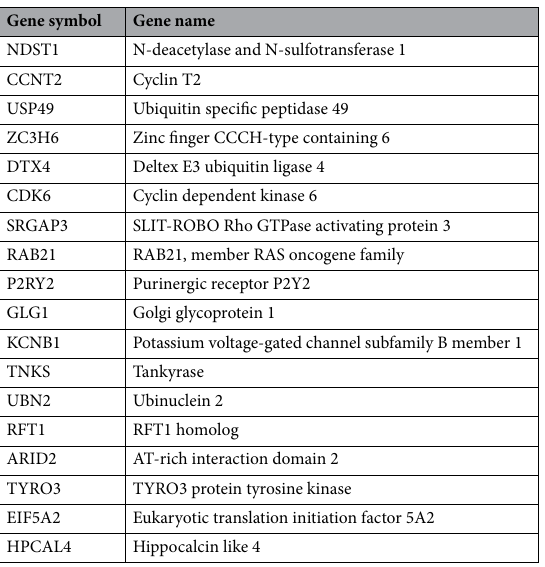
Table 5. hsa-miR-140-3p and hsa-miR-30b common targets. These targets were selected by crossing information coming from the http:// mirdb. org/ and http:// www. targe tscan. org/ databases.